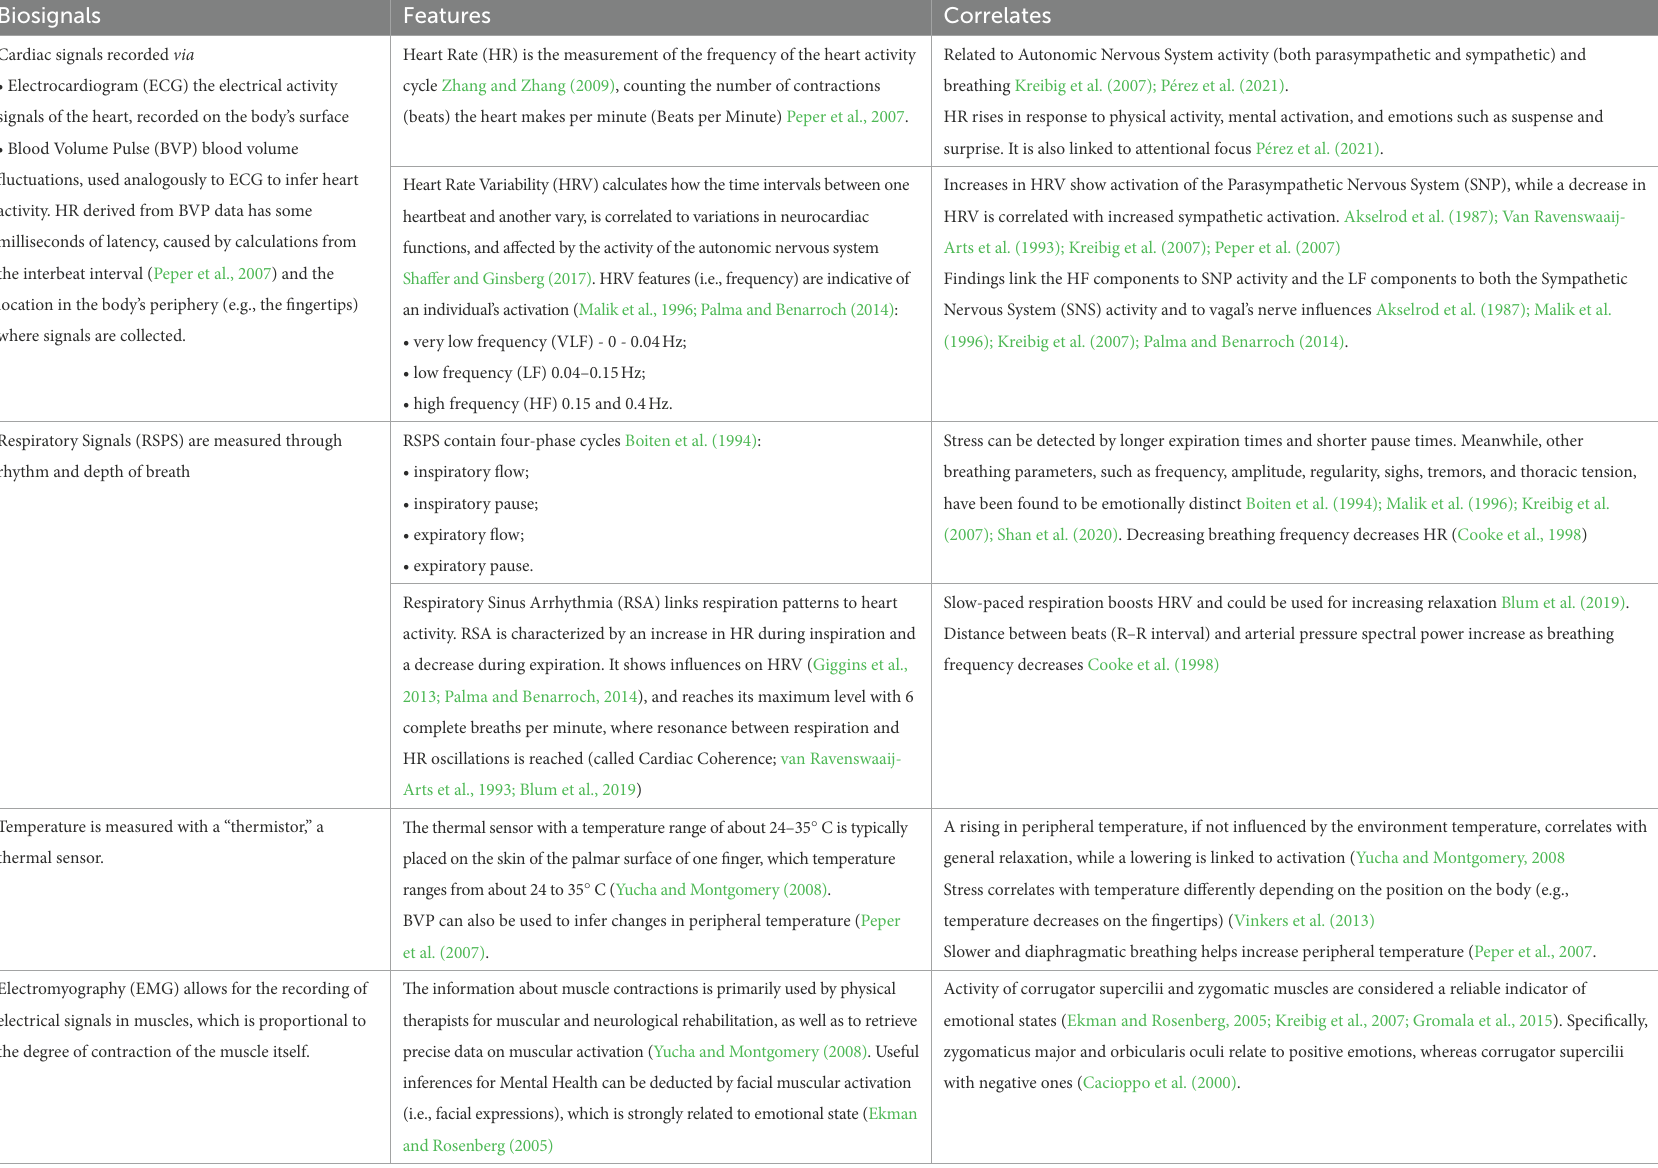
TABLE 1 Description of biosignals more frequently used in mental health with their respective features and psychological correlates.